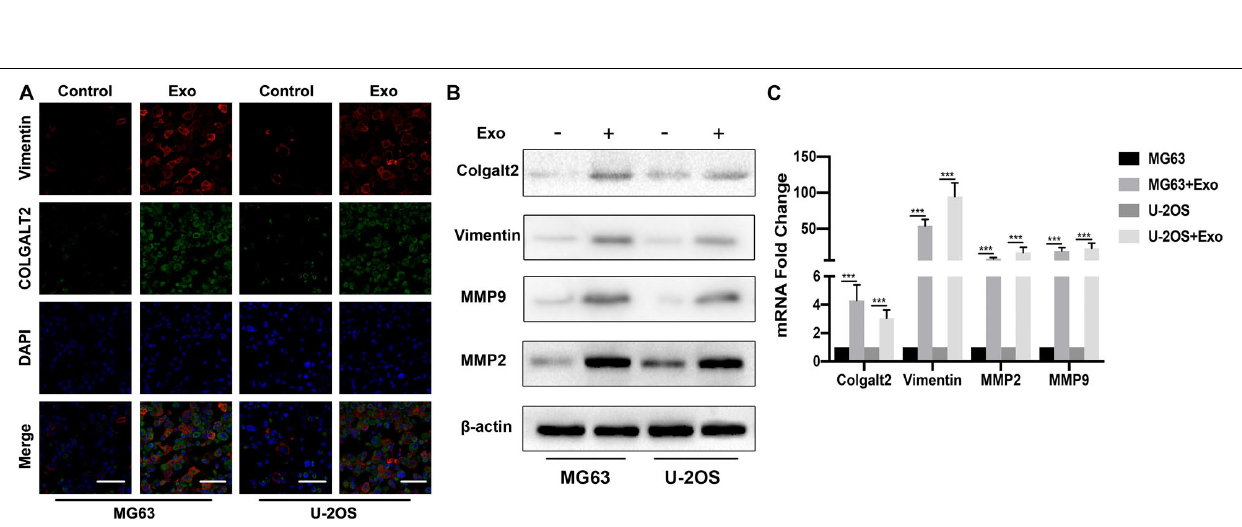
Frontiers in Cell and Developmental Biology |